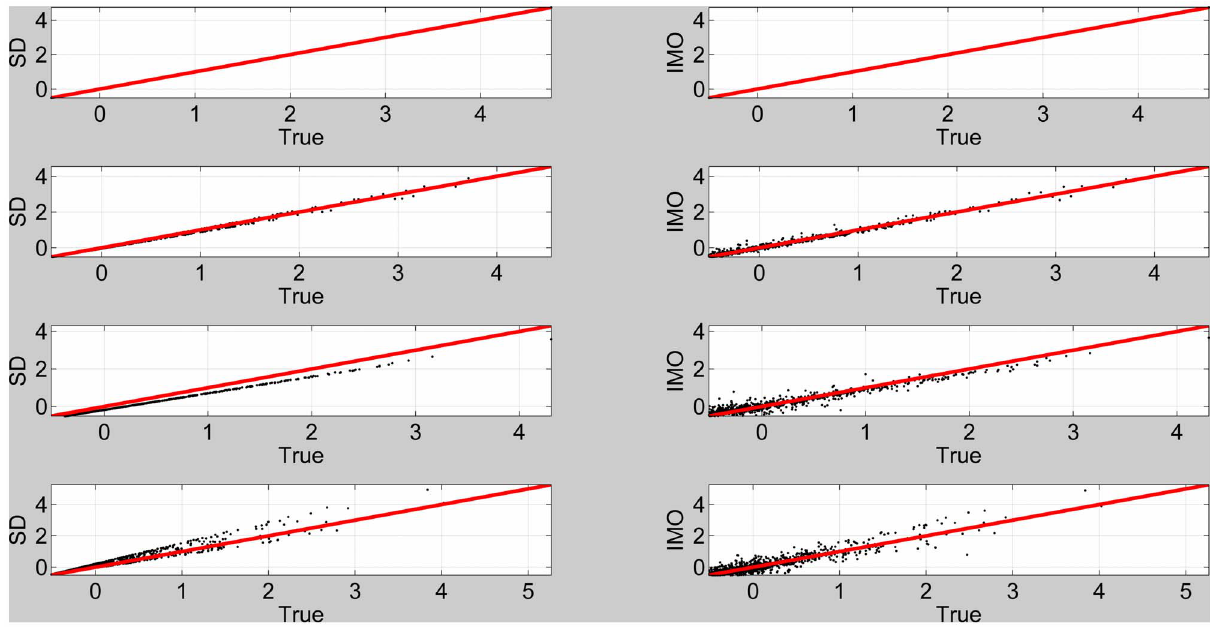
Figure 6. Left Panel: Savage-Dickey log Bayes factor versus true log Bayes factors for four levels of variability in prior precisions. Right Panel: IMO log Bayes factor versus true log Bayes factors for four levels of variability in prior precisions. These are 0% (first row), 17% (second row), 33% (third row) and 50% (last row).